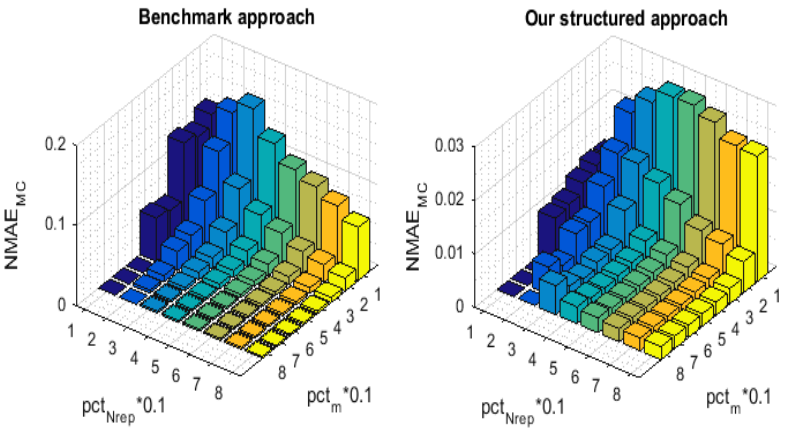
Figure 7. NMAE MC for the proposed technique and for the Benchmark.